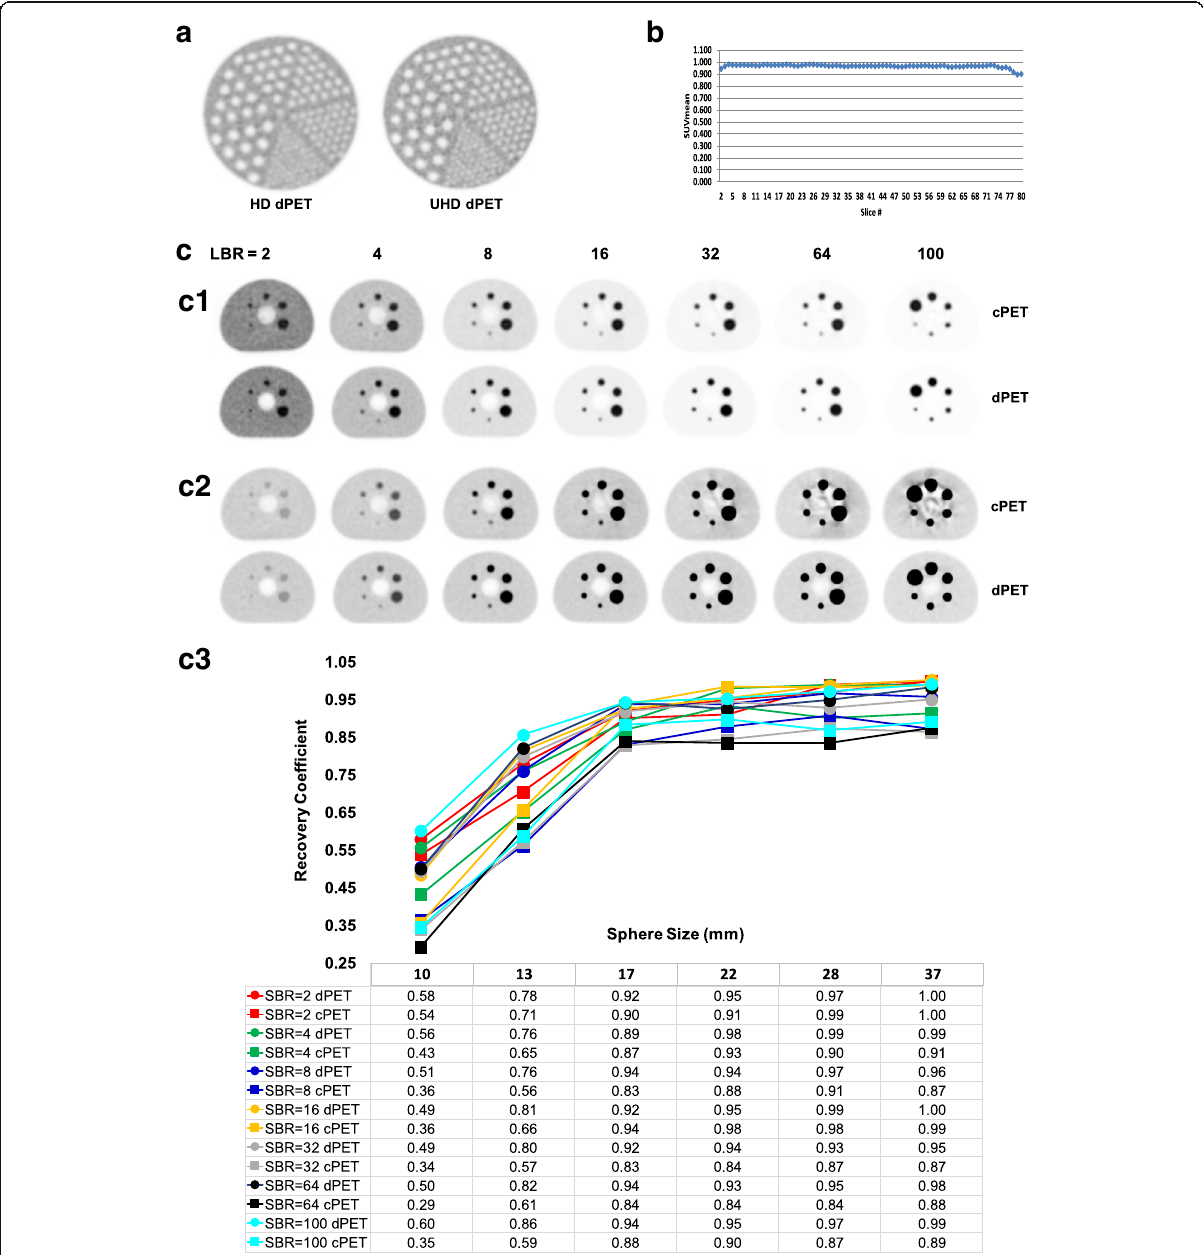
Fig. 8 Image quality of dPET via various phantom measurements. a HD and UHD dPET images of the ACR phantom cold rods. b CQIE dPET uniformity. c Comparison of dPET vs cPET of the NEMA IEC Body phantom images at different SBRs: (c1) window-level setting: SUV LL = 0, UL = SUV max of cPET at each SBR; (c2) window-level setting: same background with SUV LL = 0, UL = 5.0; (c3) RCs of dPET vs cPET as a function of sphere sizes (10 – 37 mm) at different SBRs (2 –